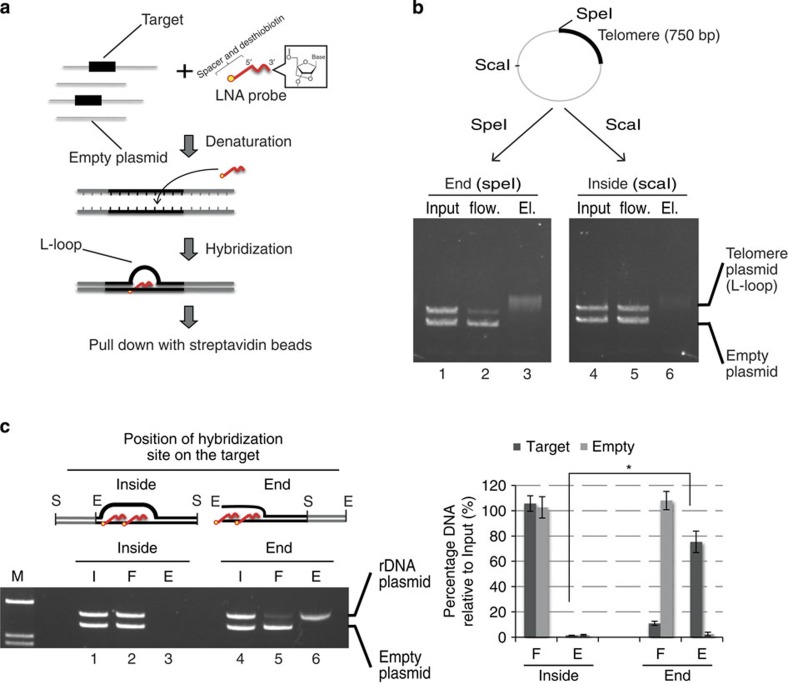
Rules for designing capture probes for the formation of stable oligo-DNA hybrids.(a) Outline of the plasmid pull-down assay. Linearized plasmids (grey line) with or without the target DNA sequence (black thick line) are mixed with LNA probes conjugated to spacers (straight red line) and desthiobiotin (yellow circle). After denaturation, the mixture is incubated at 37 °C for hybridization. Hybrids are captured using streptavidin beads. (b) Purification of the telomere sequence containing plasmid with the telomere-specific probe. Each fraction (Input, Flow-through (Flow.), Eluate (El.)) was analysed by agarose gel electrophoresis and EtBr staining. The positions of plasmid containing telomere DNA and the empty vector are indicated. Linear plasmid with telomere sequence after digestion with SpeI was used for an assay (lane 1–3 in the left panel), and linear plasmid digested by ScaI was used for the other assay (lane 4–6 in the right panel). The captured band is less intense and upshifted due to the presence of the 750-bp long L-loop. The plasmid map shows the location of telomere sequence and the two restriction sites used (SpeI and ScaI). (c) rDNA-containing plasmid and empty plasmid were cut in the backbone region with SacI (S) to yield the target site for probes 1 and 2 inside the construct, or were digested with EcoRI (E) to yield the target site on the end of the fragment. (I, input; F, Flow-through; E, Eluate). Right panel: Histogram quantifying target capture (error bars represent standard deviations. Asterisks denote significance, *P<0.001 from a student-t test). Plasmid maps not on scale.